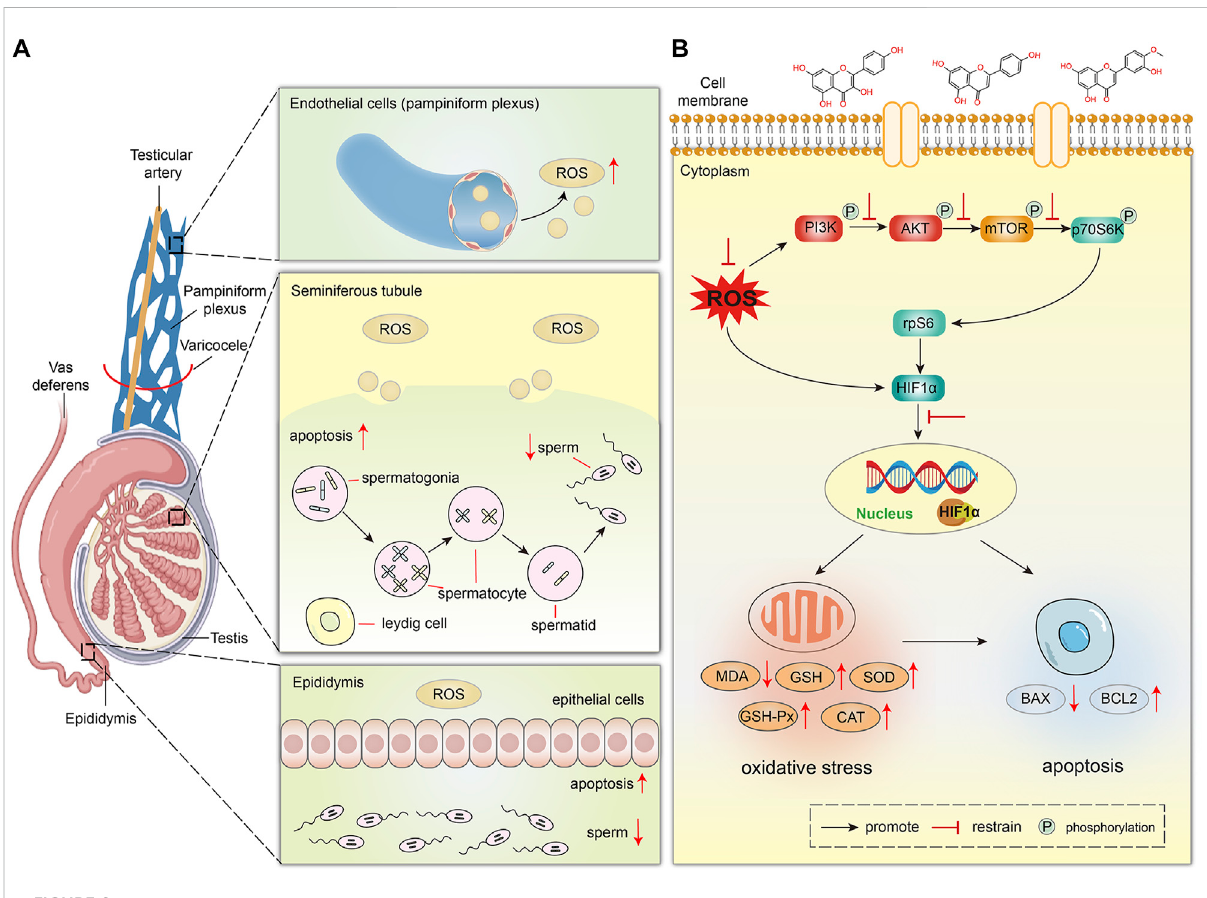
FIGURE 9 The proposed schematic diagram of MLST against varicocele-associated male infertility. (A) Effect of VC on testicular spermatogenesis in rats. (B) Mechanism of MLST against varicocele-associated male